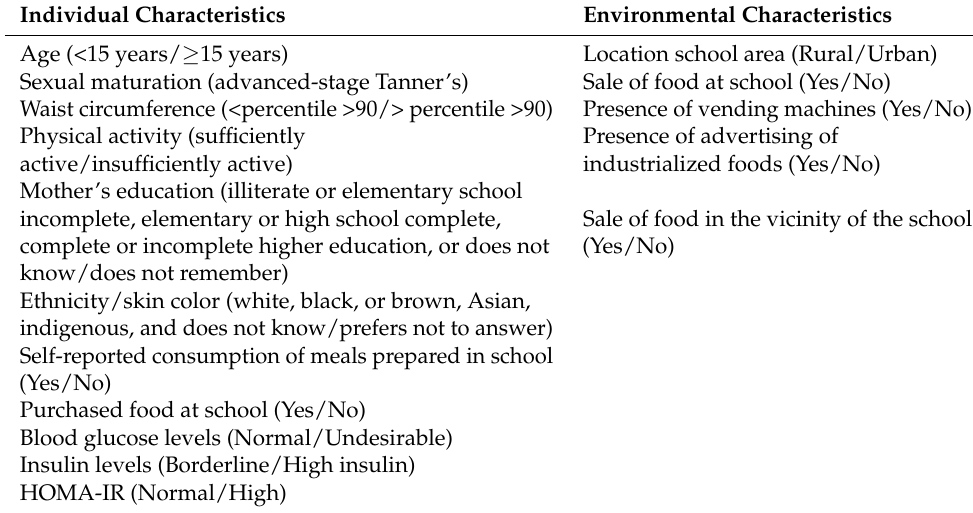
Table 1. Individual and environmental characteristics variables. Study of Cardiovascular Risks in Adolescents (ERICA), Brazil,